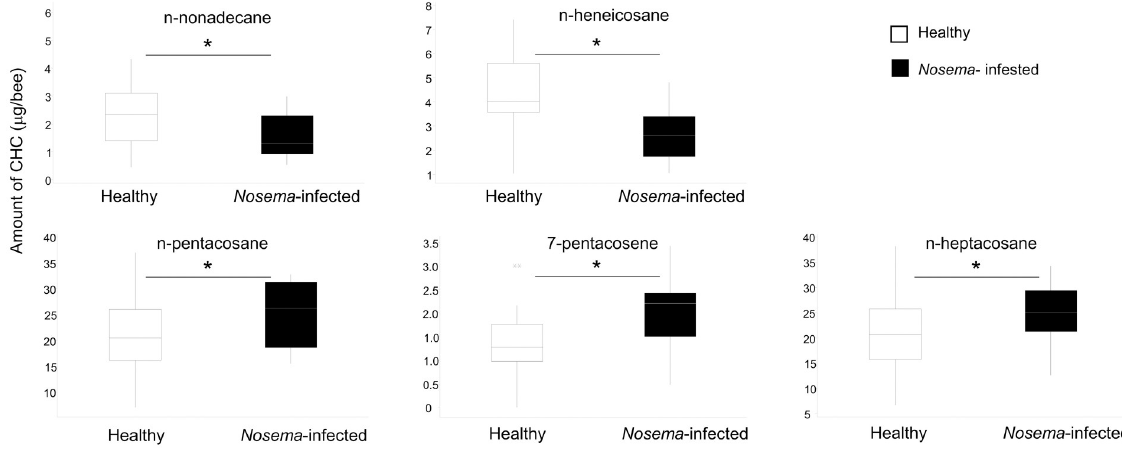
Fig 6. Boxplot of the 5 compounds where significant differences were found between healthy and Nosema -infected honeybees. ANOVA-GLM, 2-factors, P > 0.05 for diet and P < 0.05 for health status for the 5 compounds, see S2–S4 Tables for the complete statistical